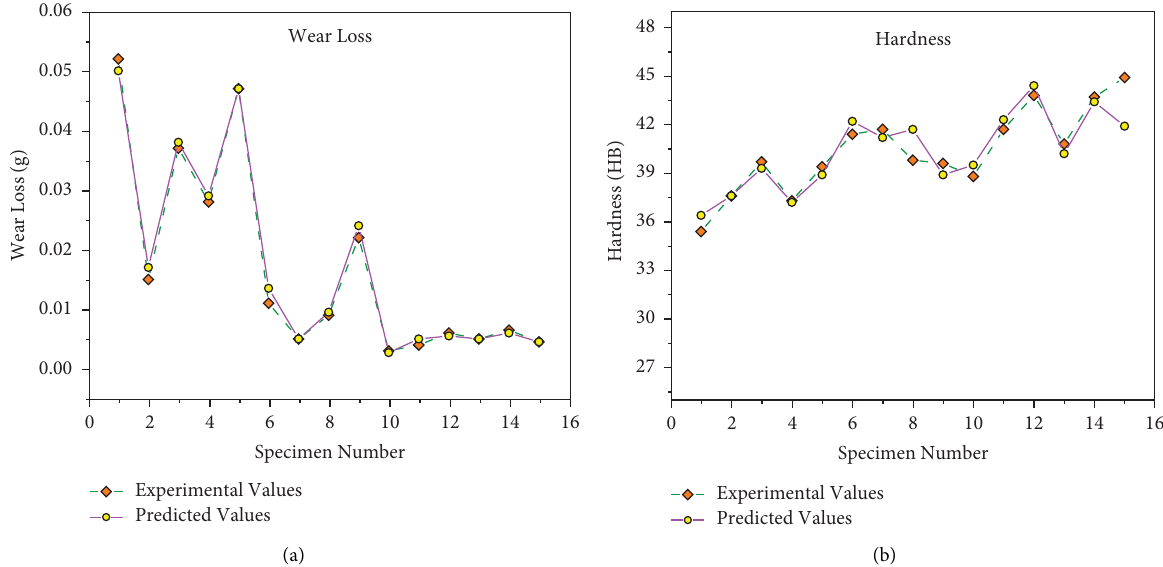
Figure 4: Evaluation of the experimented values and theoretical values (a) wear loss and (b) hardness.